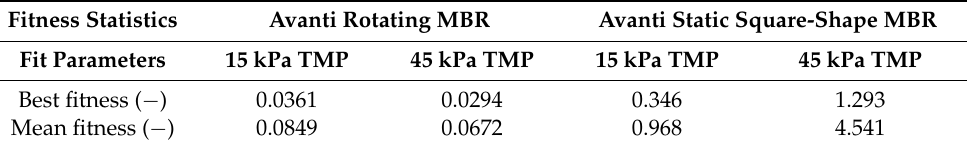
Table 4. Statistics with fitness values from simulations as computed in